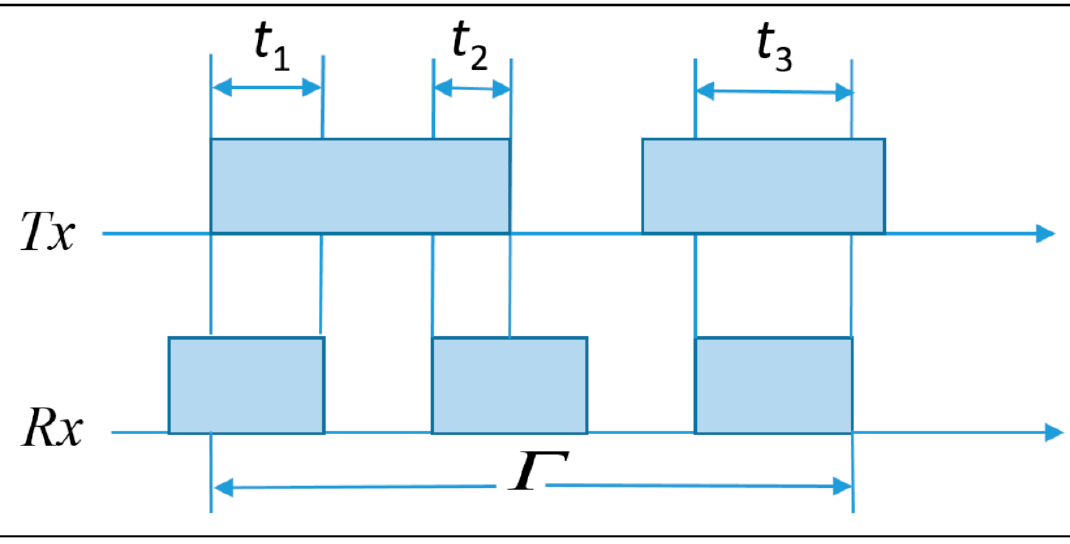
Figure 2. Encounter duration of Tx and Rx.